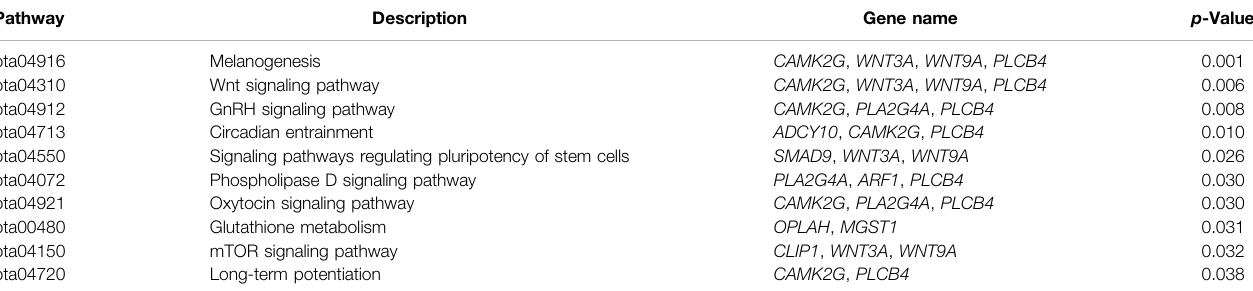
TABLE 3 | Details of the Kyoto Encyclopedia of Genes and Genomes (KEGG) pathways signi fi cantly enriched from the nearest genes and the genes within 200 kb of the signi fi cant single-nucleotide polymorphisms (SNPs). Pathway